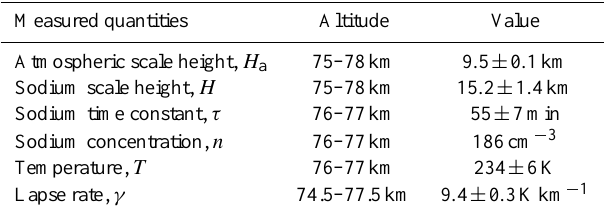
Table 1. Measured quantities based on lidar observations of MIL and sodium layer on 17–18 February 2009 at Chatanika (65 ◦ N, 147 ◦ W).